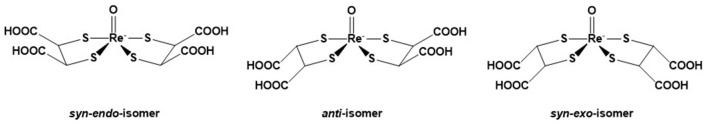
188Re-DMSA isomers.